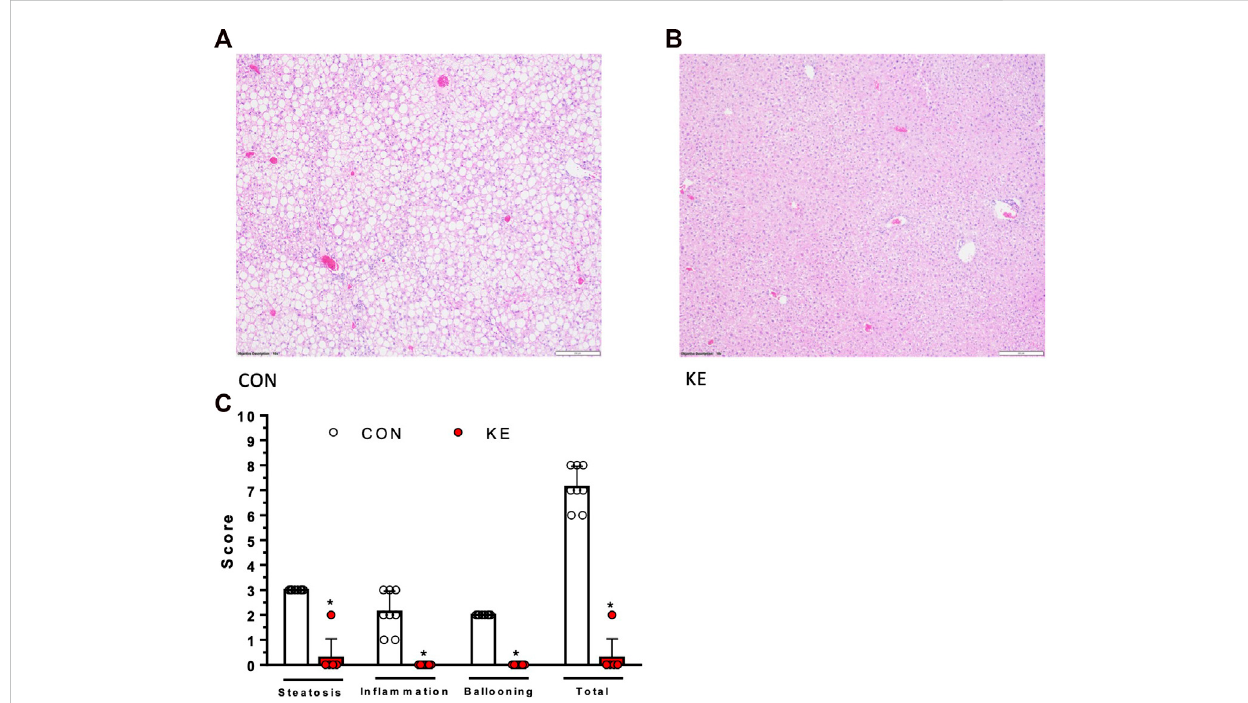
FIGURE 4 Differencesin liver phenotype assessedat study completion. (A), (B) Representative hematoxylin and eosin images of liver morphology. CON group hasgreateraccumulationoflipidscomparedtoKE. (C) Differencesinnon-alcoholicfattyliverdiseaseactivityscore(NAS;fataccumulation,in fl ammation, and hepatocellular ballooning), calculated by grading and scoring liver specimens. Values are presented as means ± SD. p < 0.05, * indicates signi fi cant differences between groups.